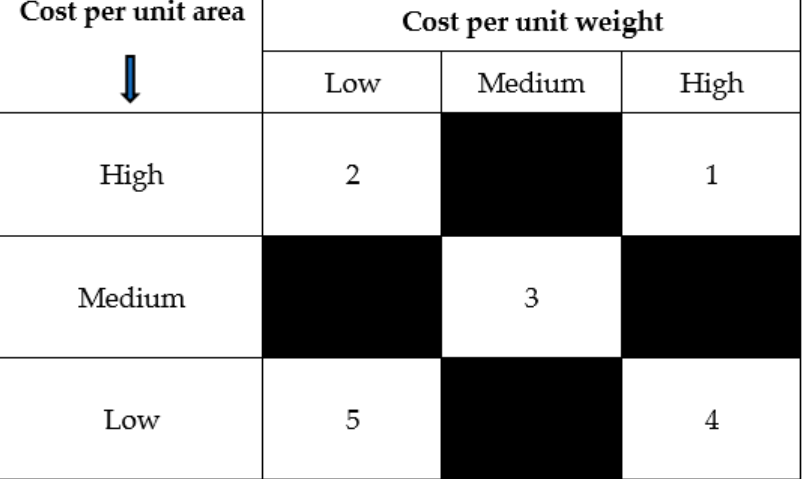
Figure 1. Categorization of products.